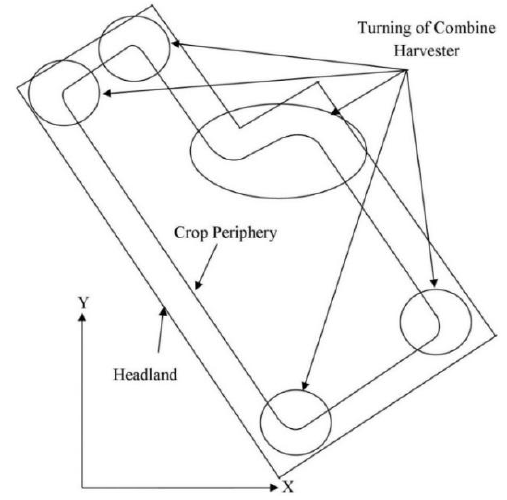
Figure 1. A polygonal field with a circle representing the turning area of the tracked combine harvester .